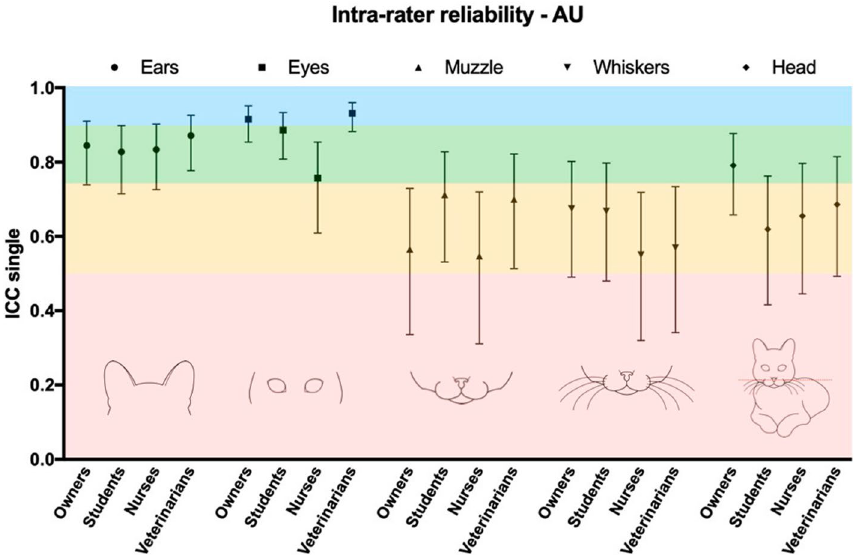
Figure 3. Intra-rater reliability of the action units (AU) composing the Feline Grimace Scale by raters with different degrees of expertise in feline pain assessment. Intra-rater reliability was assessed using a two-way mixed effects intra-class correlation coefficient (ICC) for absolute agreement (raters: n = 5/group). Estimates for ICC single measures, accompanied by their 95% confidence intervals are presented. Interpretation was as following: ICC < 0.5 = poor (pink), 0.5–0.75 = moderate (yellow), 0.75–0.9 = good (green), and > 0.90 = excellent reliability (blue) 34 . The veterinarian group was composed by individuals with experience in pain